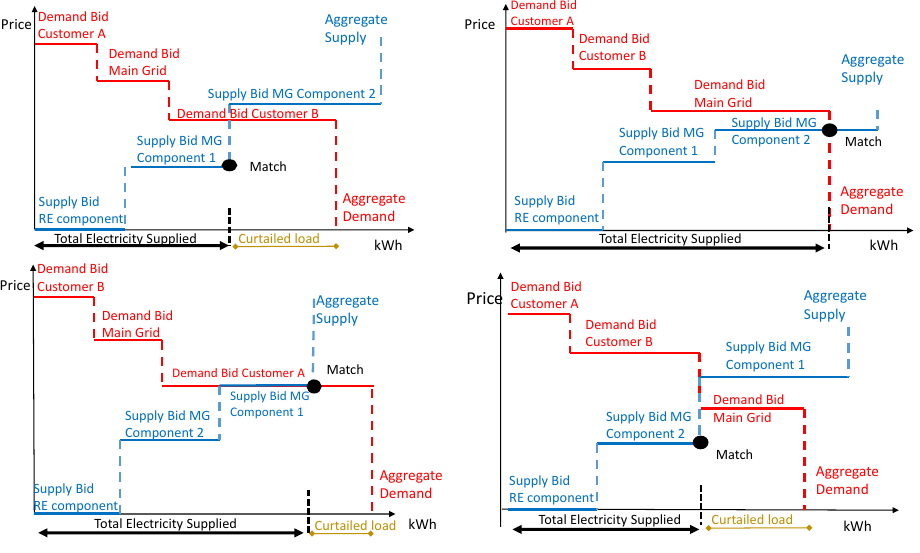
Figure 3. Different possible hourly UMG demand and offer